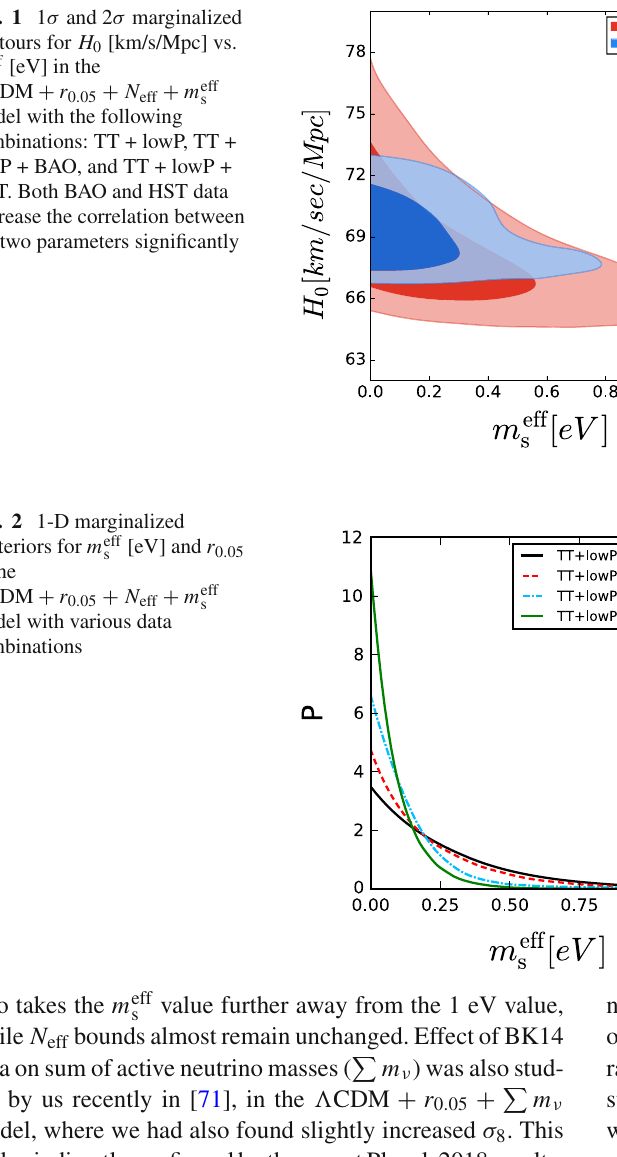
Fig. 1 1 σ and 2 σ marginalized contours for H 0 [km/s/Mpc] vs. m eff s [eV] in the (cid:2) CDM + r + N + m eff eff 0 . 05 s model with the following combinations: TT + lowP, TT + lowP + BAO, and TT + lowP + HST. Both BAO and HST data decrease the correlation between the two parameters significantly